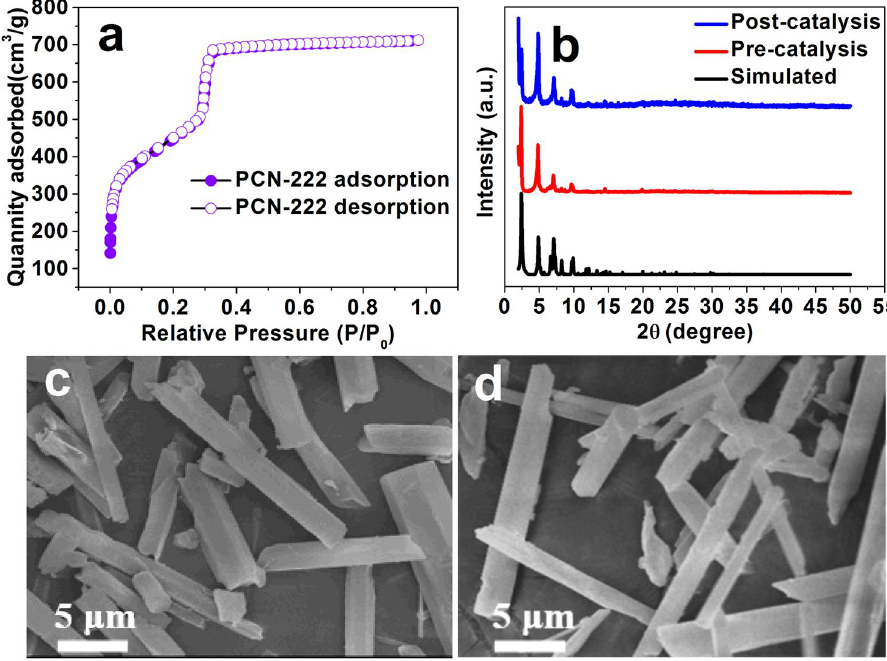
Figure 1. ( a ) The nitrogen adsorption-desorption isotherms of PCN-222 at 77 K. ( b ) PXRD patterns of PCN- 222 for the simulated, pre-catalysis and post-catalysis samples. SEM images of ( c ) pre-catalysis PCN-222 and ( d ) PCN-222 after 5-cycles